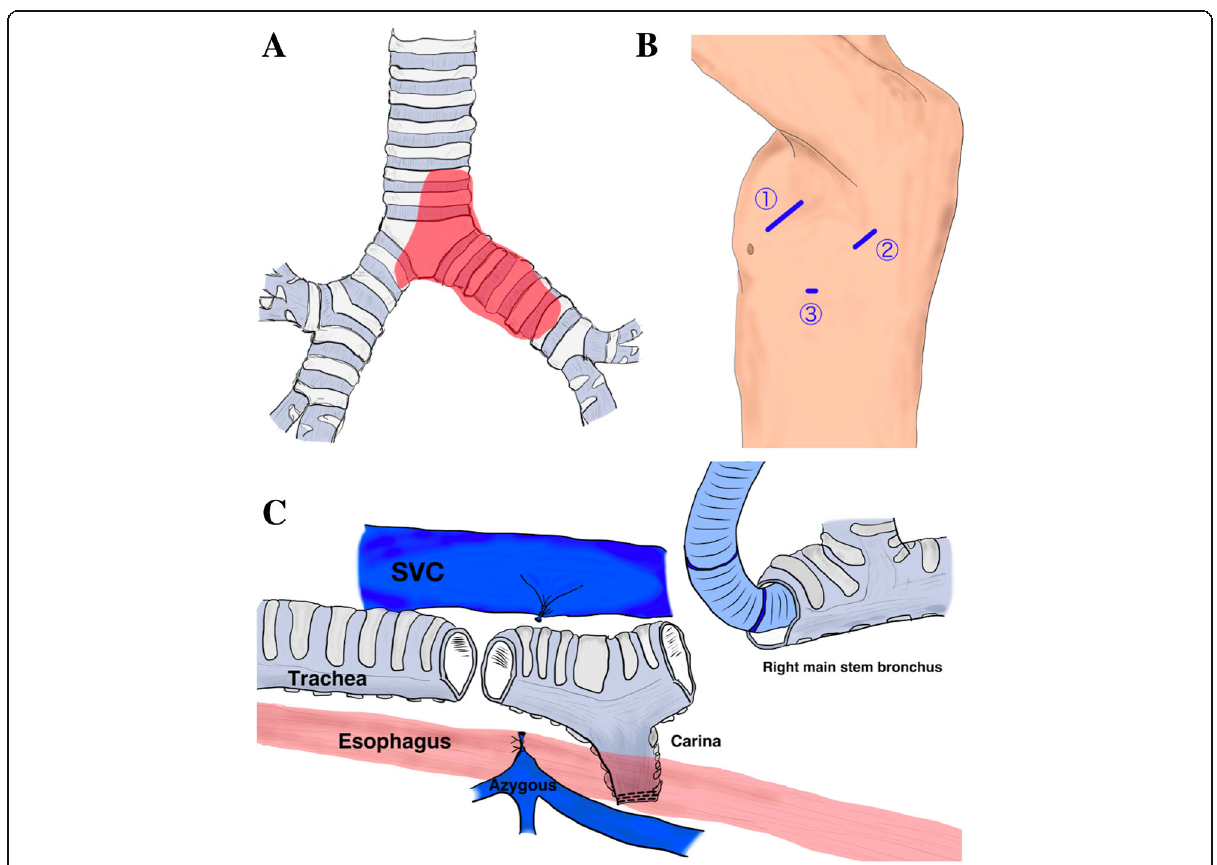
Fig. 3 Schematic figures. a Tumor location. b c-VATS establishment: ① Access window, 4th intercostal space, 50 mm; ② Assist window, 6th intercostal space, 40 mm; ③ Camera port, 7th intercostal space, 12 mm. c Posterolateral thoracotomy, the carinal resection and